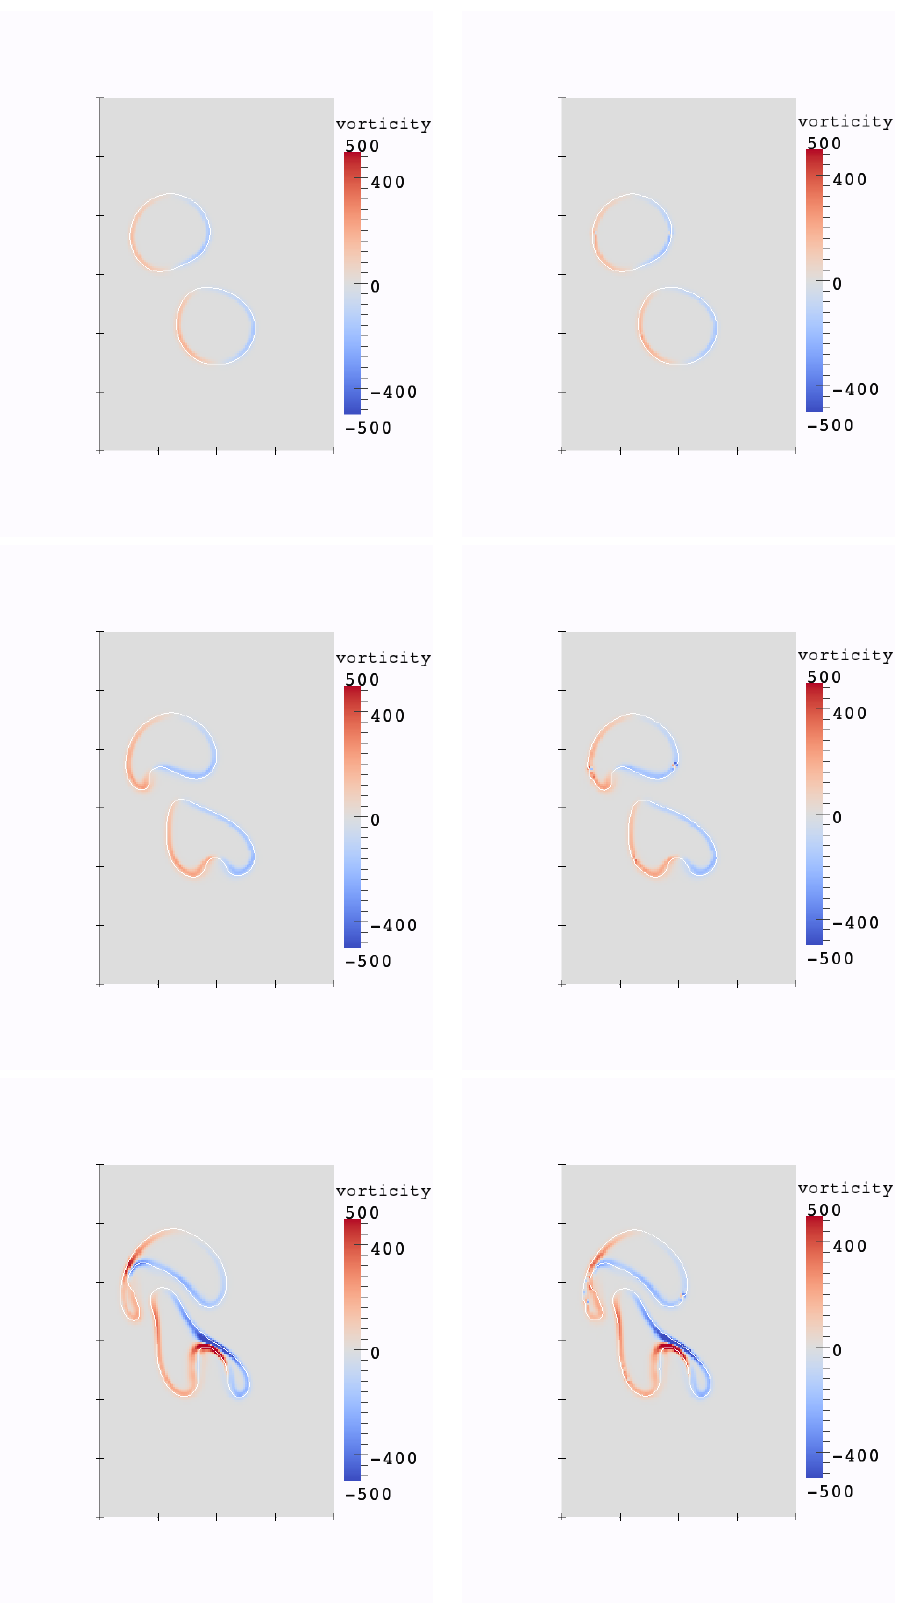
Figure 13. Evolution of the interface and vorticity values for the two bubbles test case at times t = 0.,0.04,0.08,0.12, resolution 120 × 180, ( left ): new method for pressure, ( right ): Ghost Fluid method for